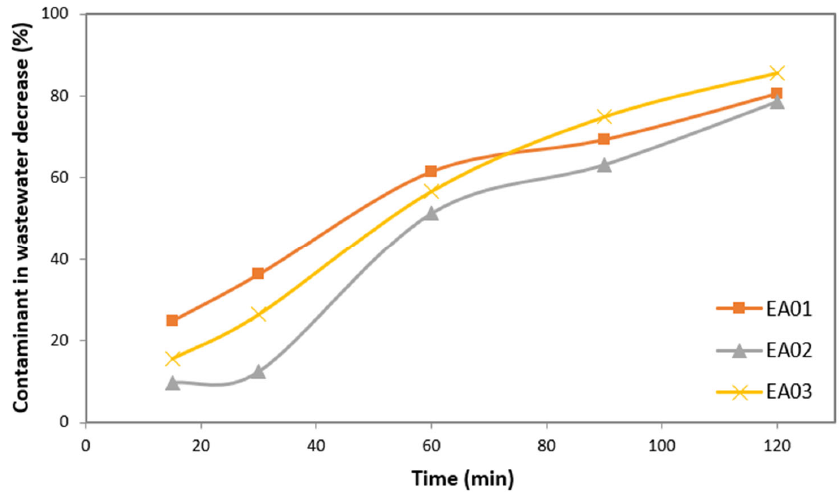
Figure 8. Pollutant decreases by adsorption of the volcanic material (black sand) in absence of light (EA01: pH 5.36, photocatalyst 0.12 g/L, MB 50 ppm; EA02: pH 5.44, photocatalyst 0.12 g/L, MB 50 ppm; EA03: pH 5.36, photocatalyst 0.12 g/L, MB 50 ppm).